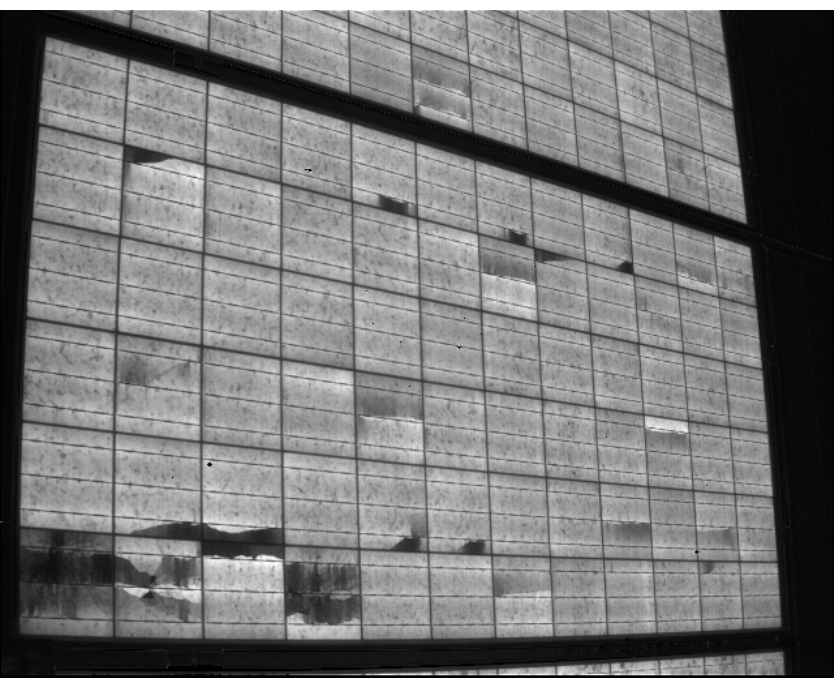
Figure A1. Original DaySy ™ electroluminescence (EL) image of Solarzentrum Stuttgart GmbH affected by barrel lens distortion. Straight line structures in the PV module are represented by curved line structures in the image.